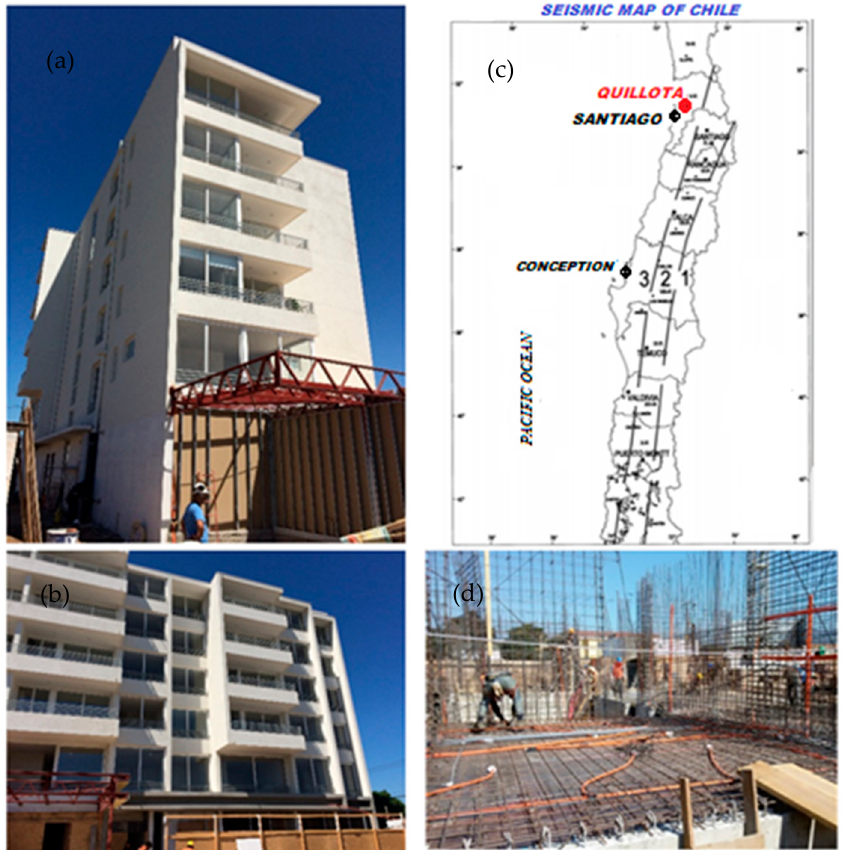
Figure 2. ( a , b ) Case-study building in the city of Quillota ( c ) seismic zones in central Chile. In the seismic map, Chile is divided into three bands numbered from 1 to 3, the latter being the higher seismic hazard band, to which Quillota belongs and ( d ) Details of the shear walls reinforcement.